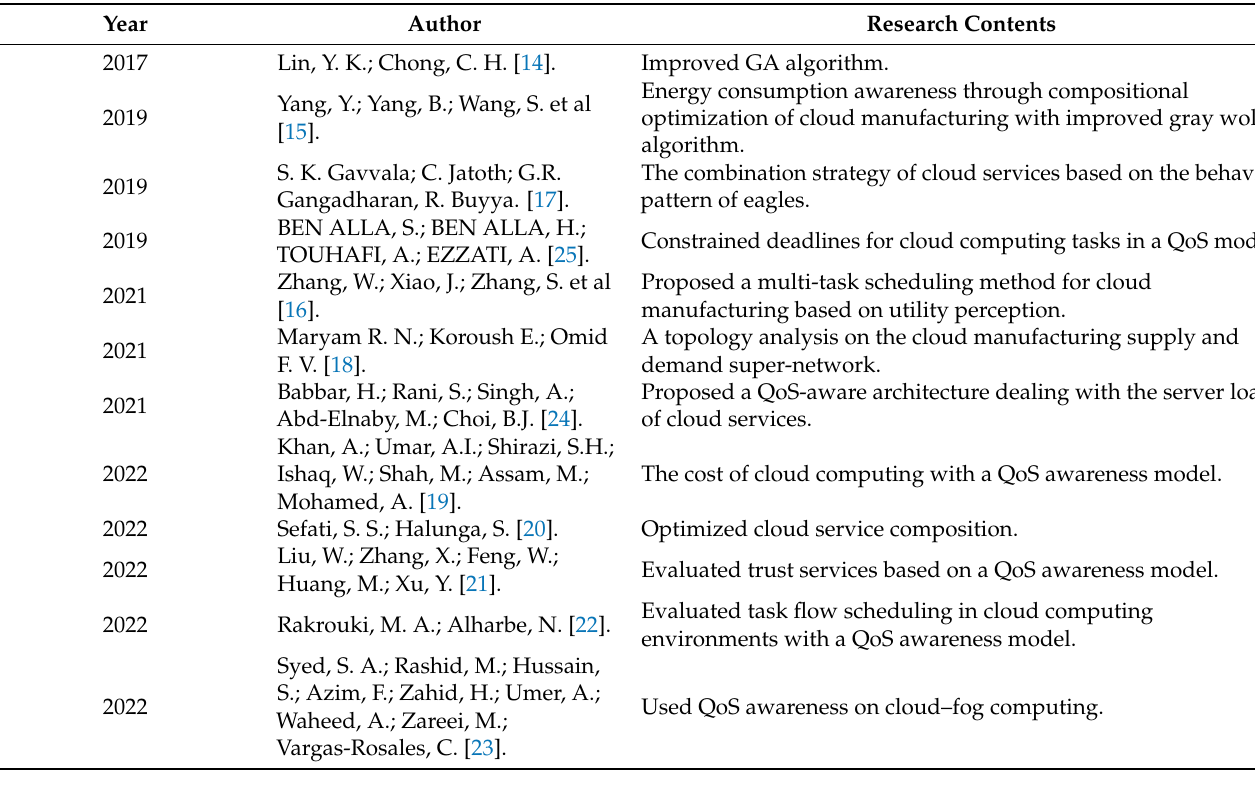
Table 2. Researchers and studies related to evaluation model and optimization